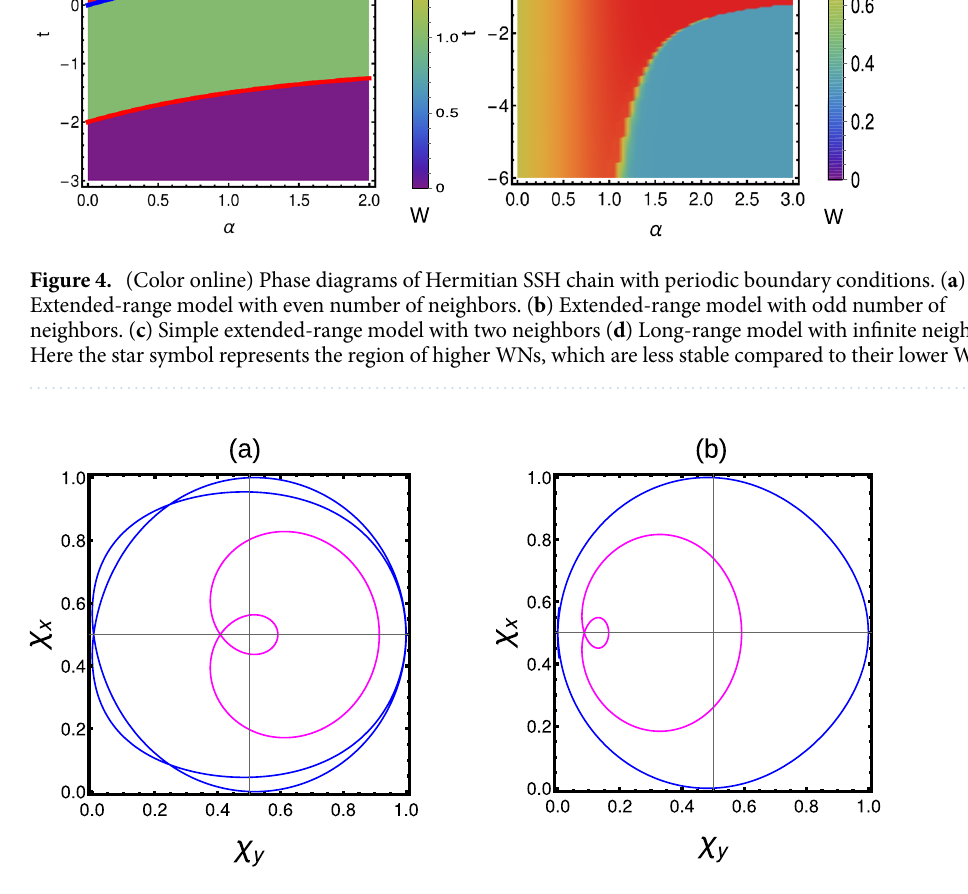
0.1 calculated using Eqs. (24) and (25) =